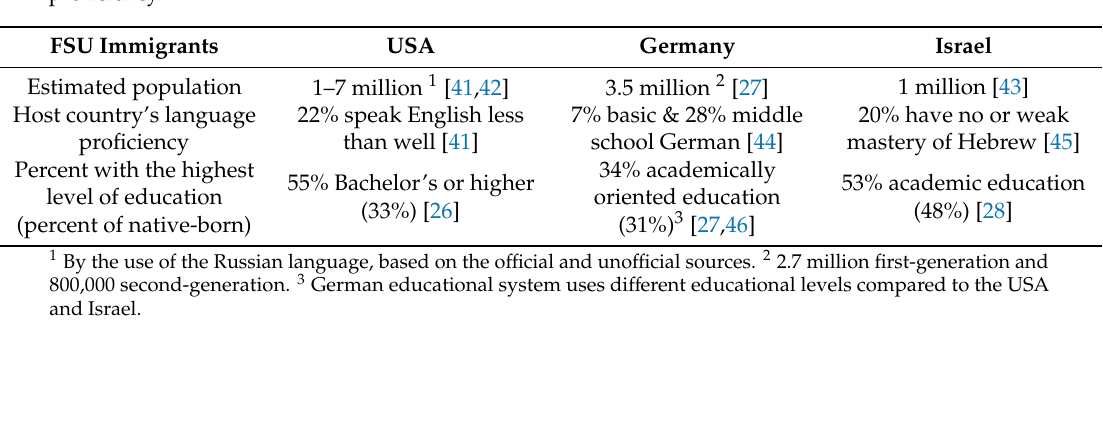
Table 1. Estimated former Soviet Union (FSU) immigrant population, education, and language